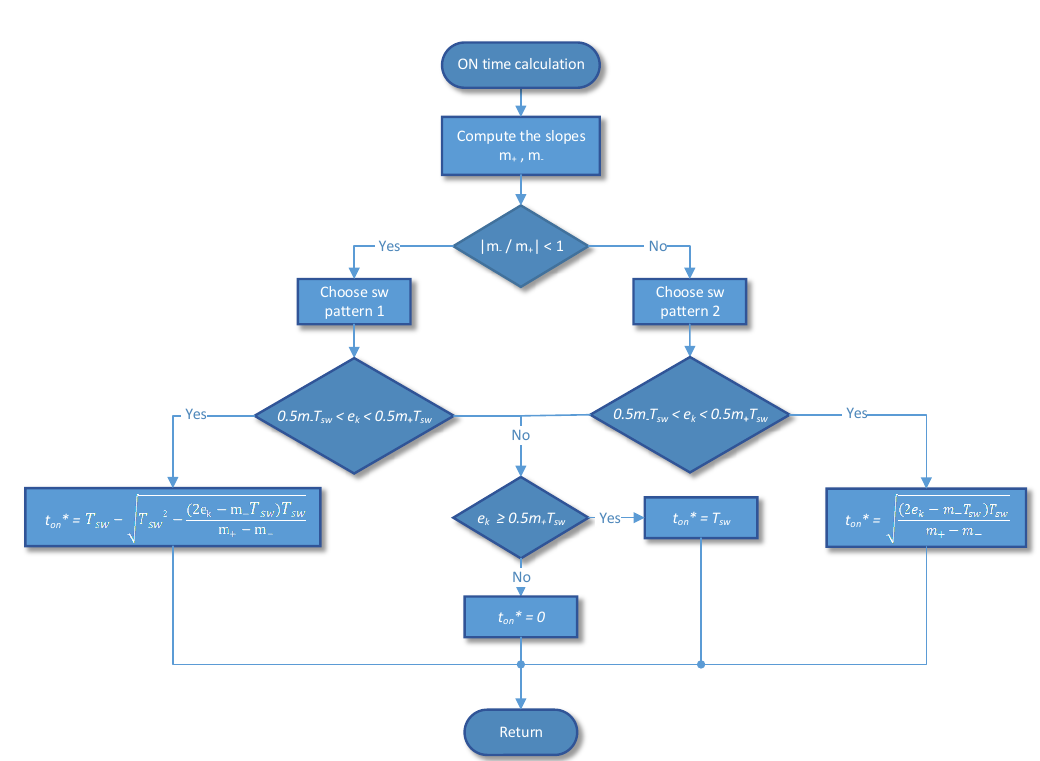
Figure 6. Flowchart of the digital control algorithm.